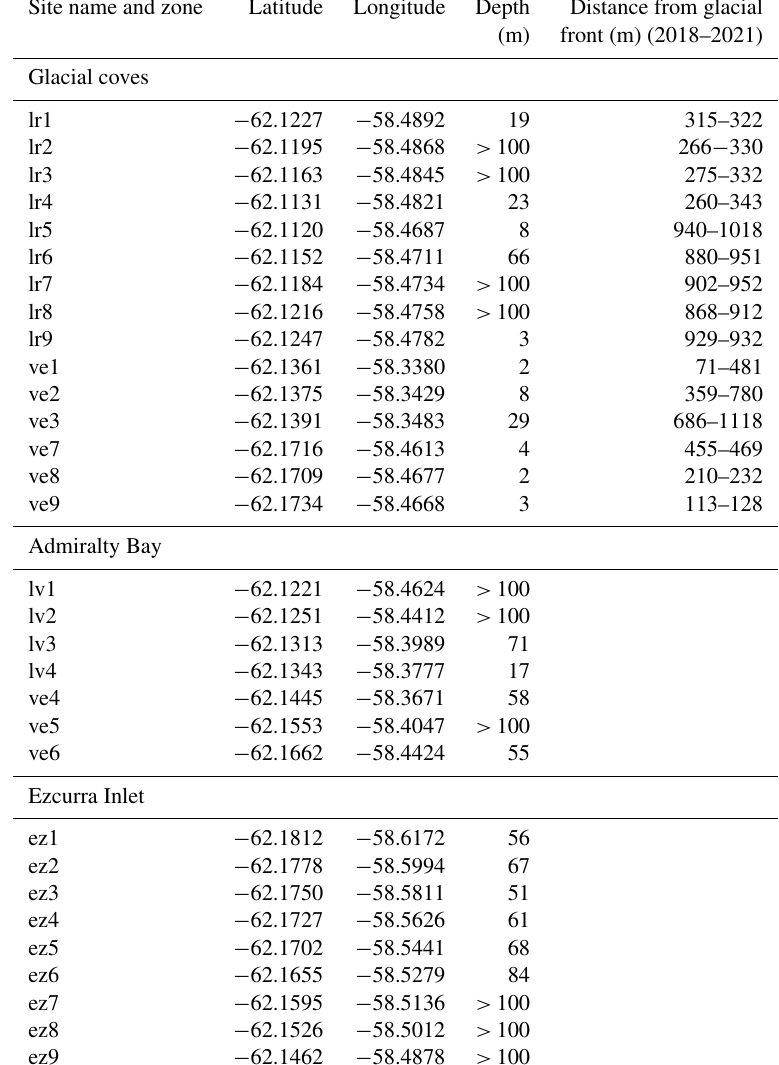
Table 1. Details of the measurement sites. The depth measurements are based on the YSI EXO sonde depth sensor; depths > 100 at a given site indicate that the sonde was lowered to the cable limits (100m) and did not reach the ocean bottom. Distances from glacial fronts were measured only for sites within smaller glacial coves adjacent to individual glaciers, as sites in Admiralty Bay and Ezcurra Inlet were influenced by a number of glaciers in their